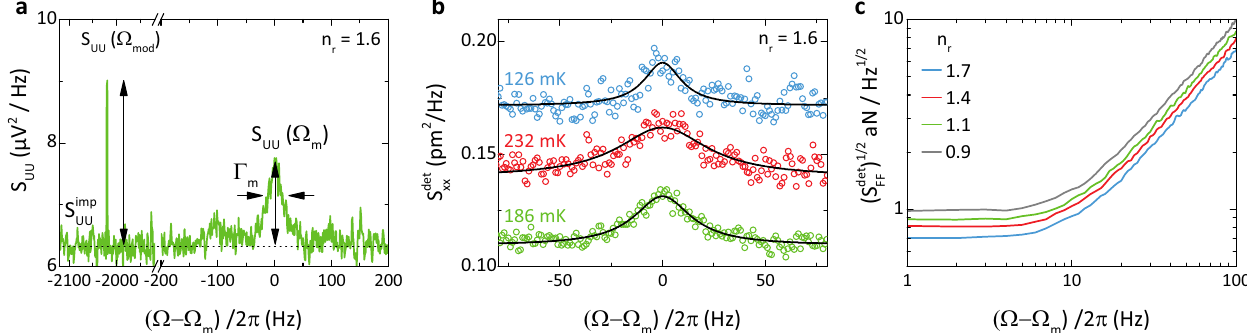
Fig. 3 Thermal mechanical displacement noise. Panel a shows the voltage noise spectral density S UU of the down-converted microwave spectroscopy tone. At Ω m /2 π = 6.34311 MHz, we observe the mechanical signature with a peak amplitude of S UU ( Ω m ) = 1.26 μ V 2 Hz − 1 and a linewidth of Γ m /(2 π ) = 33.6 Hz. In this experiment, we con fi gure the microwave spectroscopy tone to the blue sideband con fi guration ( ω p = ω c + Ω m ) to ef fi ciently detect the Stokes fi eld within the bandwidth of the resonator. However, we suppress back-action induced heating by using an ultra-weak probe tone corresponding to ¼ 1 : 6 in the microwave resonator. The sharp peak at ( Ω − Ω π ≈ − 2 kHz with an amplitude of S ð Ω Þ ¼ an average photon number of (cid:2) n m )/2 r UU mod 2 : 56 μ V 2 Hz (cid:2) 1 stems from the phase modulation of the microwave spectroscopy tone ( ϕ 0 = 3.94 × 10 − 4 ). Combining the information of the mechanical signature and the calibration peak, we fi nd an electromechanical vacuum coupling of g 0 /2 π = (1.62± 0.12) kHz. We further show the mechanical displacement density S det in panel ( b ) for T = 126 mK (blue), 186 mK (green), and 232 mK (red dots) including the Lorentzian fi ts to the data (solid lines). xx The peak area scales as expected with temperature via the mechanical linewidth. All spectra are recorded with the same averaging. Panel c shows the spectral force sensitivity S det at T = 126 mK for the microwave probe powers as indicated. On-resonance, we reach sub-attonewton force sensitivities even FF for these ultra-low microwave probe